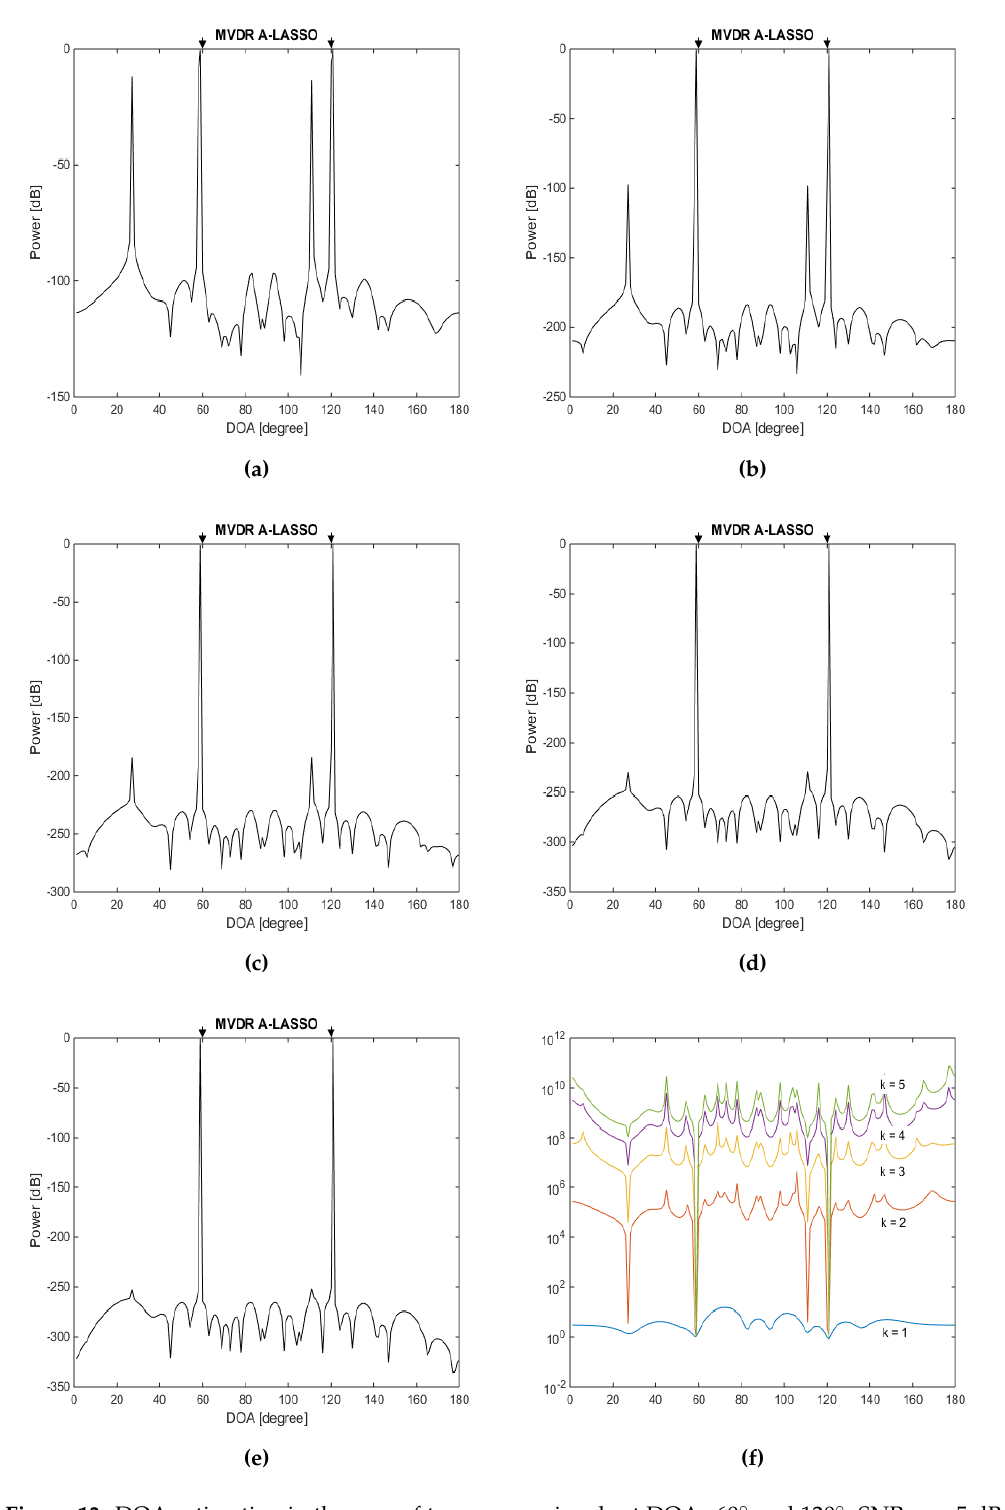
Figure 13. DOA estimation in the case of two source signals at DOAs 60 ◦ and 120 ◦ , SNR = − 5 dB, 50 snapshots using MVDR A-LASSO algorithm. ( a – e ) after 1 − 5 iterations; and ( f ) MVDR A-LASSO weights as the number of iterations k